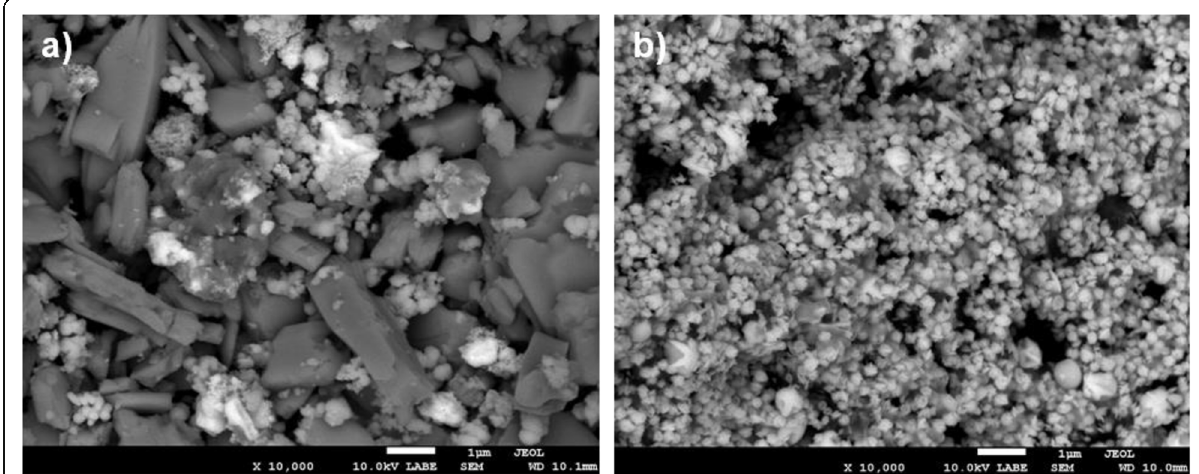
Fig. 4 SEM images of precipitates obtained by using ( A ) hydrogen peroxide and ( B ) perchloric